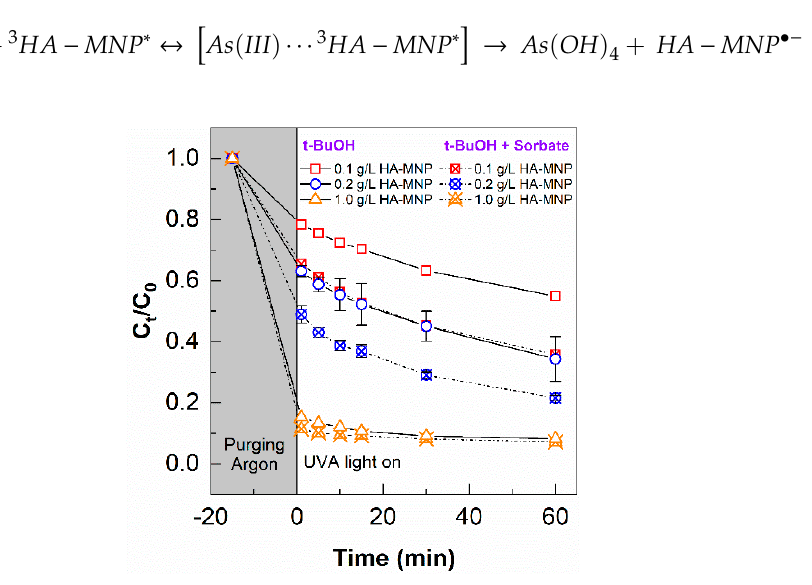
Figure 9. The removal of As(III) in the presence of • OH and 3 HA-MNP* quenchers and in the absence of molecular oxygen during photo-irradiation for 60 min. [As(III)] 0 = 200 µg L − 1 , [HA-MNP] = 0.1, 0.2, and 1.0 g L − 1 , [ t -BuOH] = 10 mM, and [sorbate] = 10 mM; error bars represent the standard deviation of triplicate measurements.